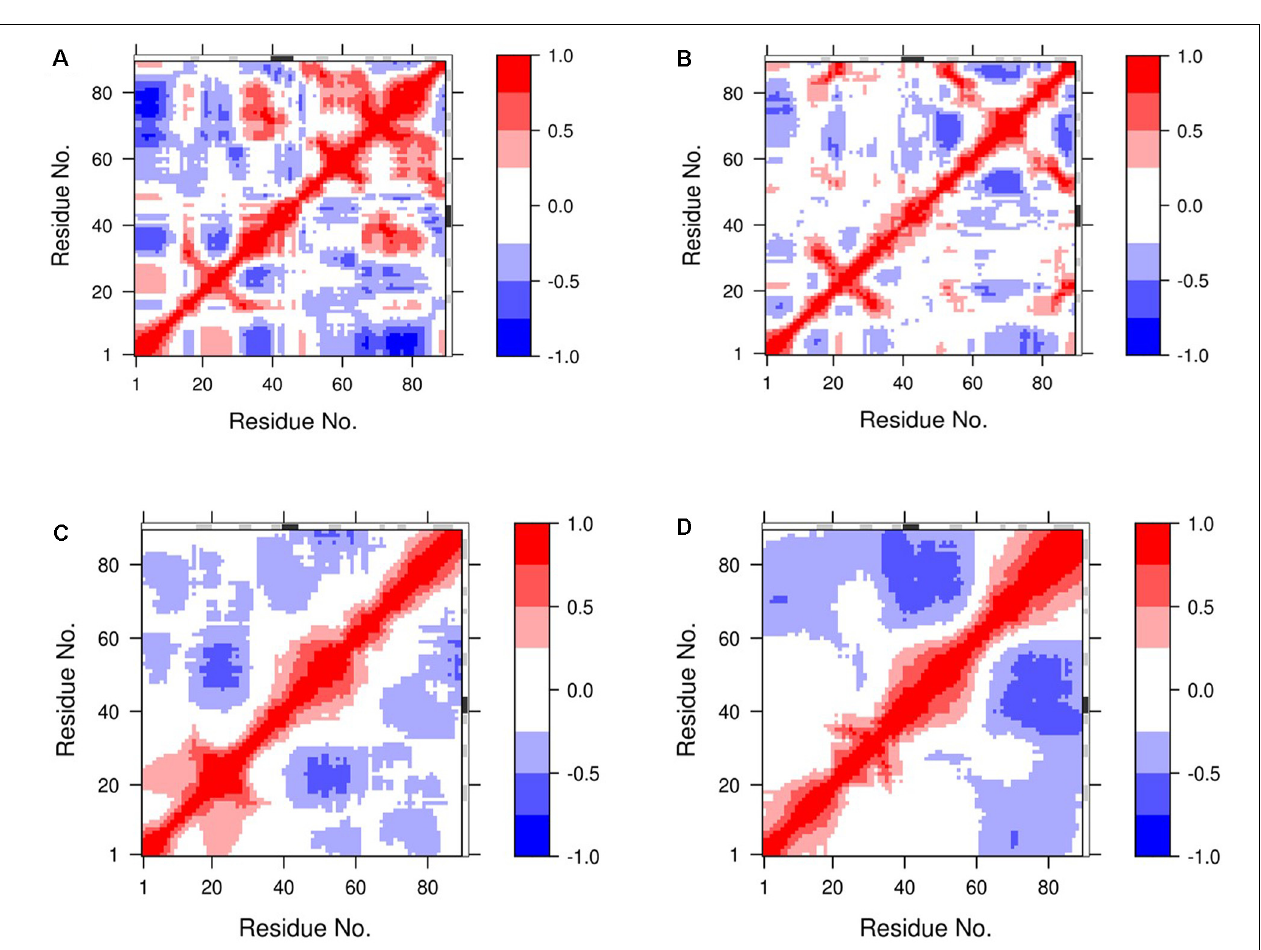
FIGURE 6 | Dynamic cross-correlation map (DCCM) of NTD’s residue motion during MD simulation. The residue motions of NTD at (A,B) 400 K, and (C,D) 450 K during the start and the end of the simulation, respectively. The degrees of the correlation motions and anti-correlation motions are shown in blue and red,